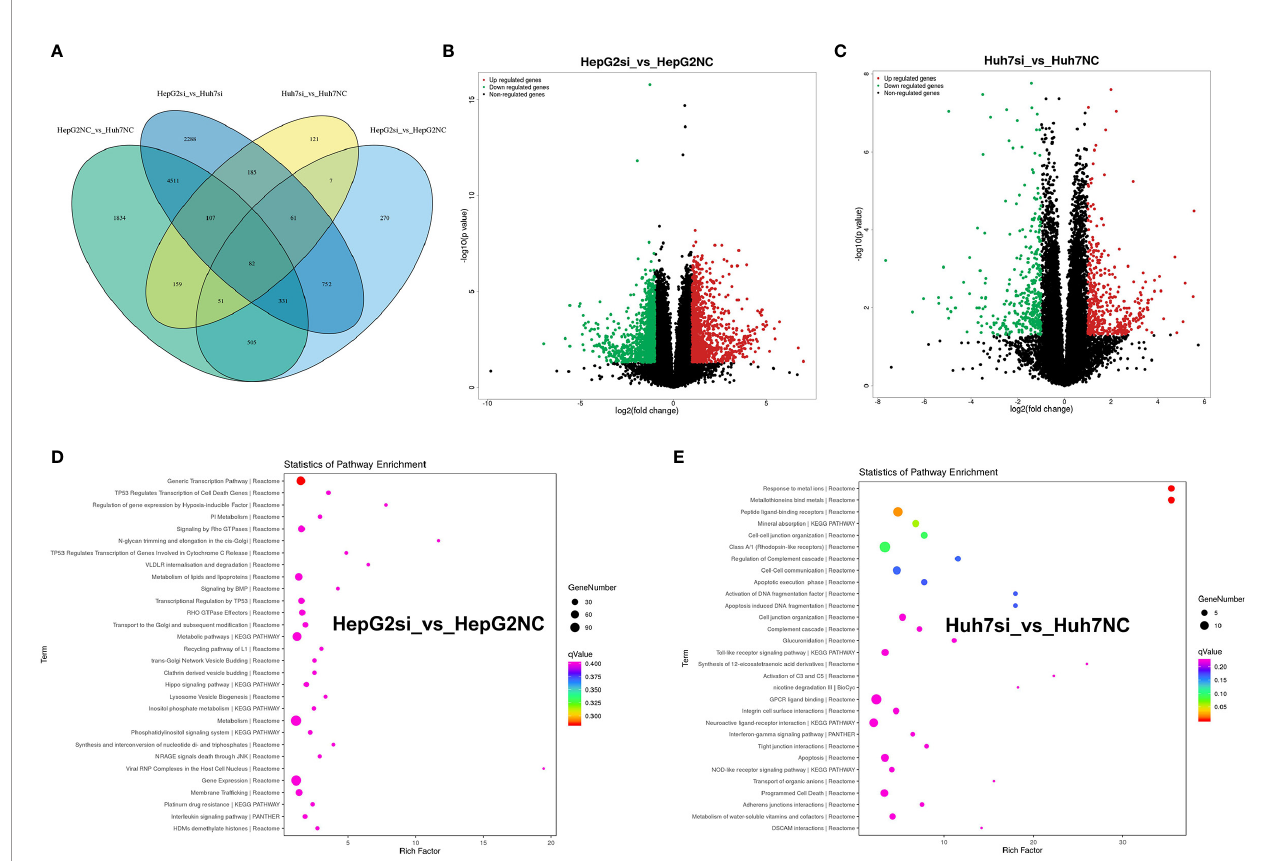
FIGURE 6 | RNA-seq analysis of HepG2 and Huh7 cells knocking down the MUC16 gene. (A) Venn diagram showing the numbers and overlap of differentially expressed genes in the 4 data sets. (B) Volcano plot displaying upregulated and downregulated mRNAs in HepG2 cells. (C) Volcano plot displaying upregulated and downregulated mRNAs of Huh7 cells. (D, E) The results of KEGG analysis of the MUC16 gene knockdown in HepG2 cells and Huh7